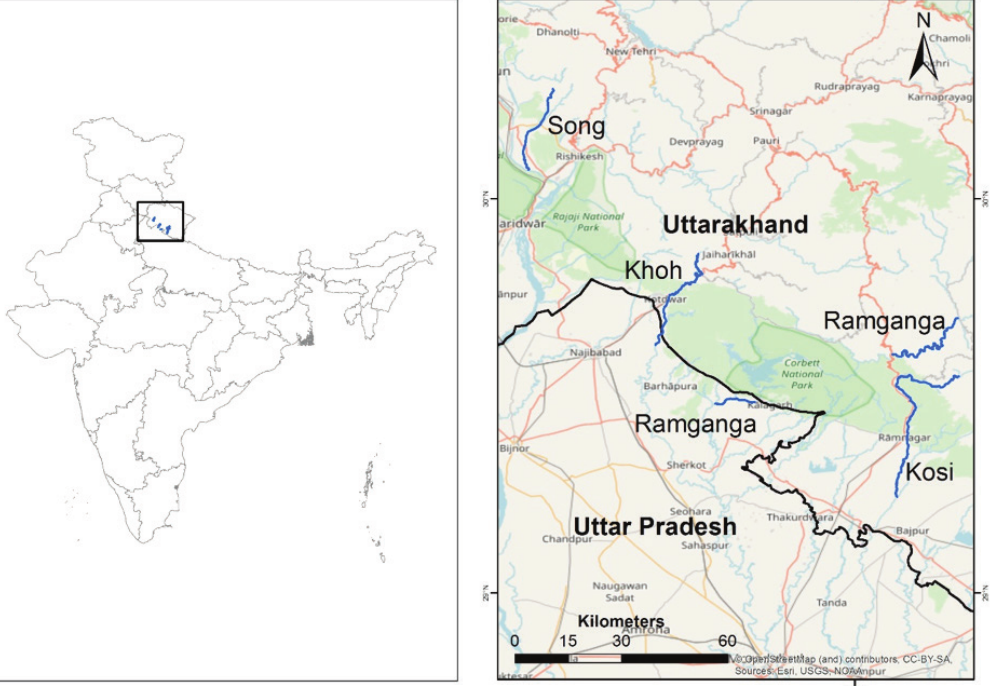
Figure 1. The study area and sampling stations. Each river stretch is labelled in blue, with each transect location spread across at every